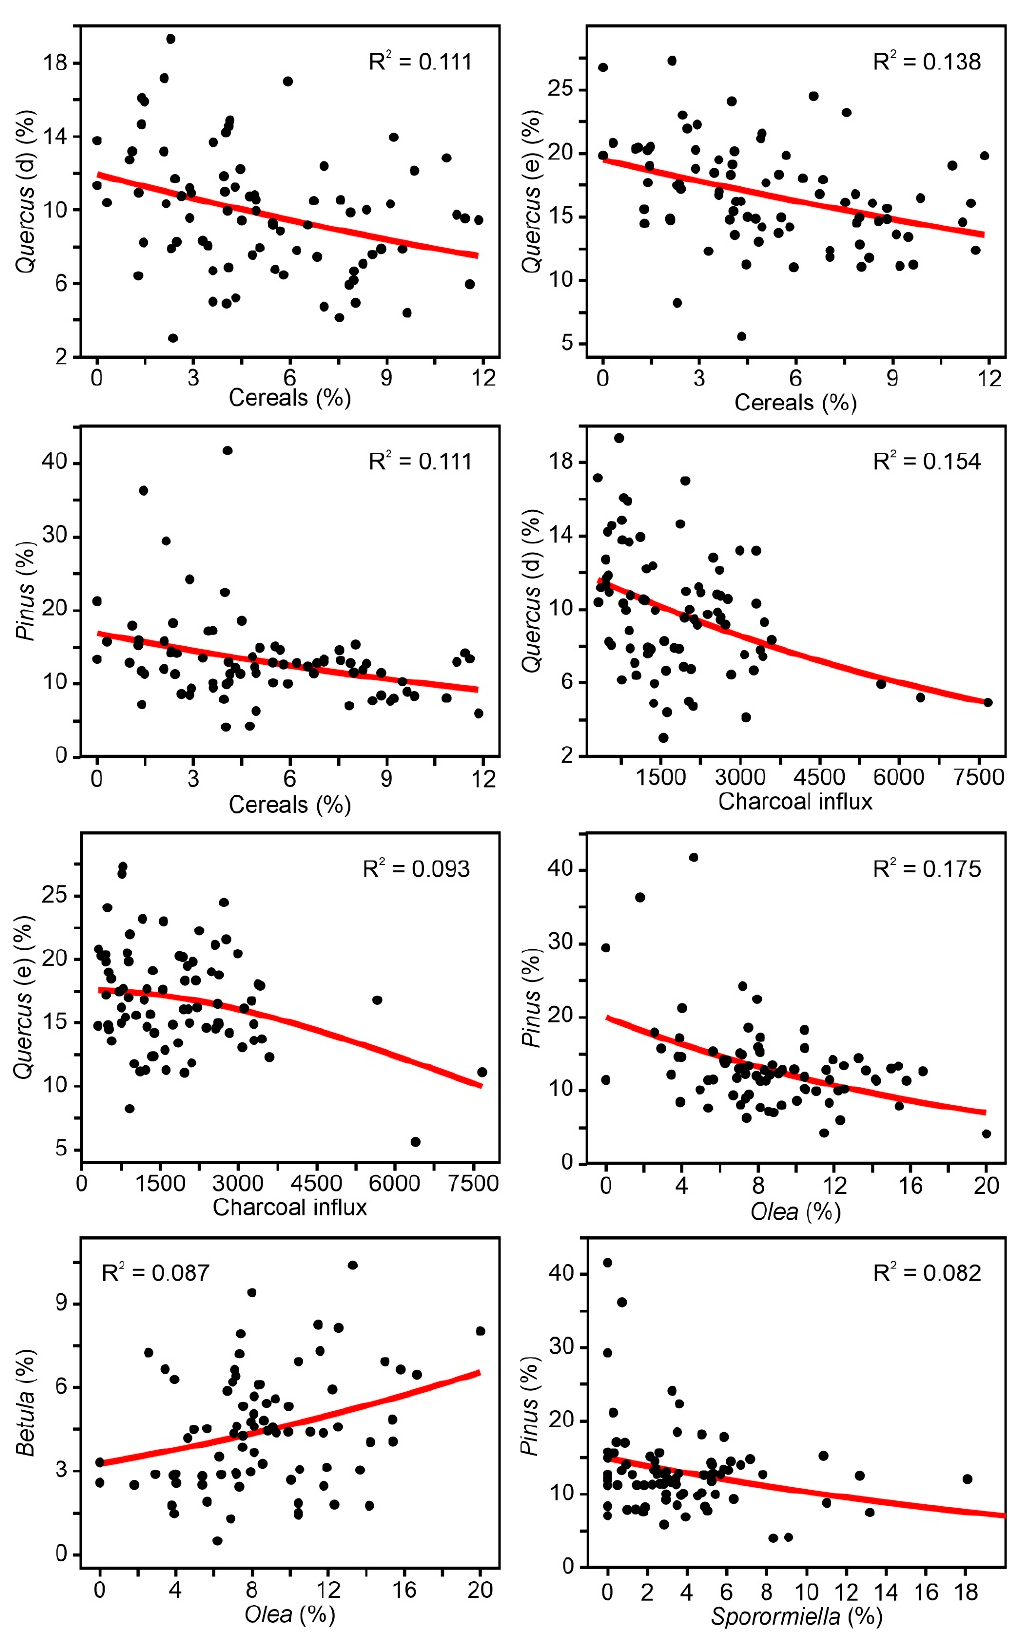
Figure 9. Forest taxa with significant Gaussian responses to anthropogenic drivers.